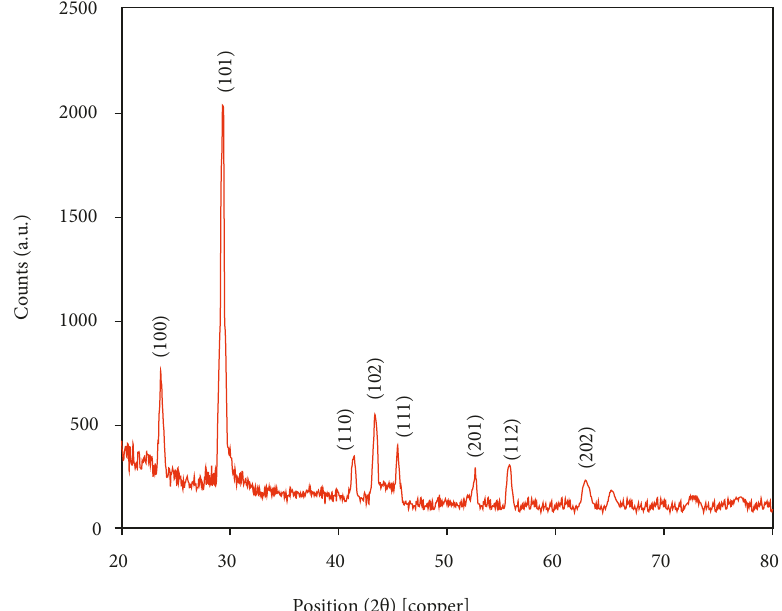
Figure 2: X-ray diffraction (XRD) patterns of selenium